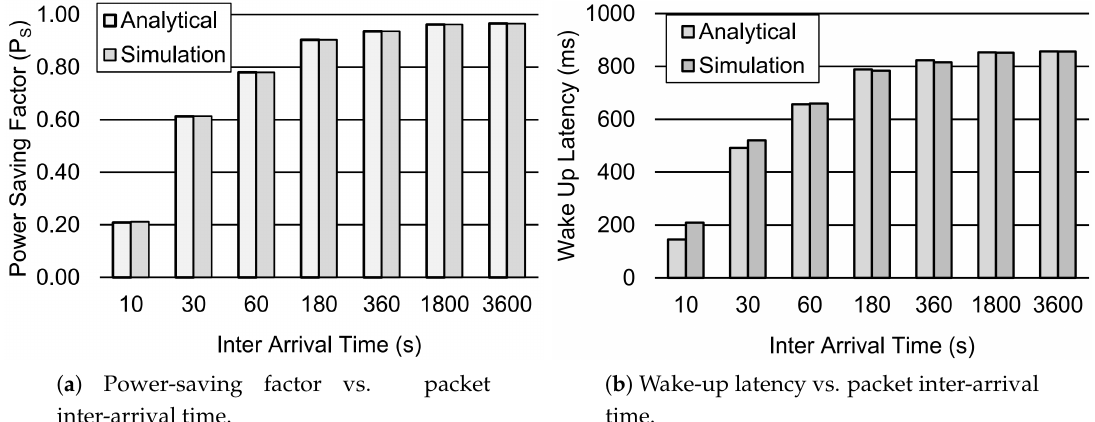
Figure 4. Performance analysis of the DRX mechanism for different values of packet inter-arrival time. Other parameter settings are T I = 20 ms, T ON = 40 ms, T SC = 0.64 s, T LC = 1.28 s, T RC = 260 ms, and T tail = 11.576 s.